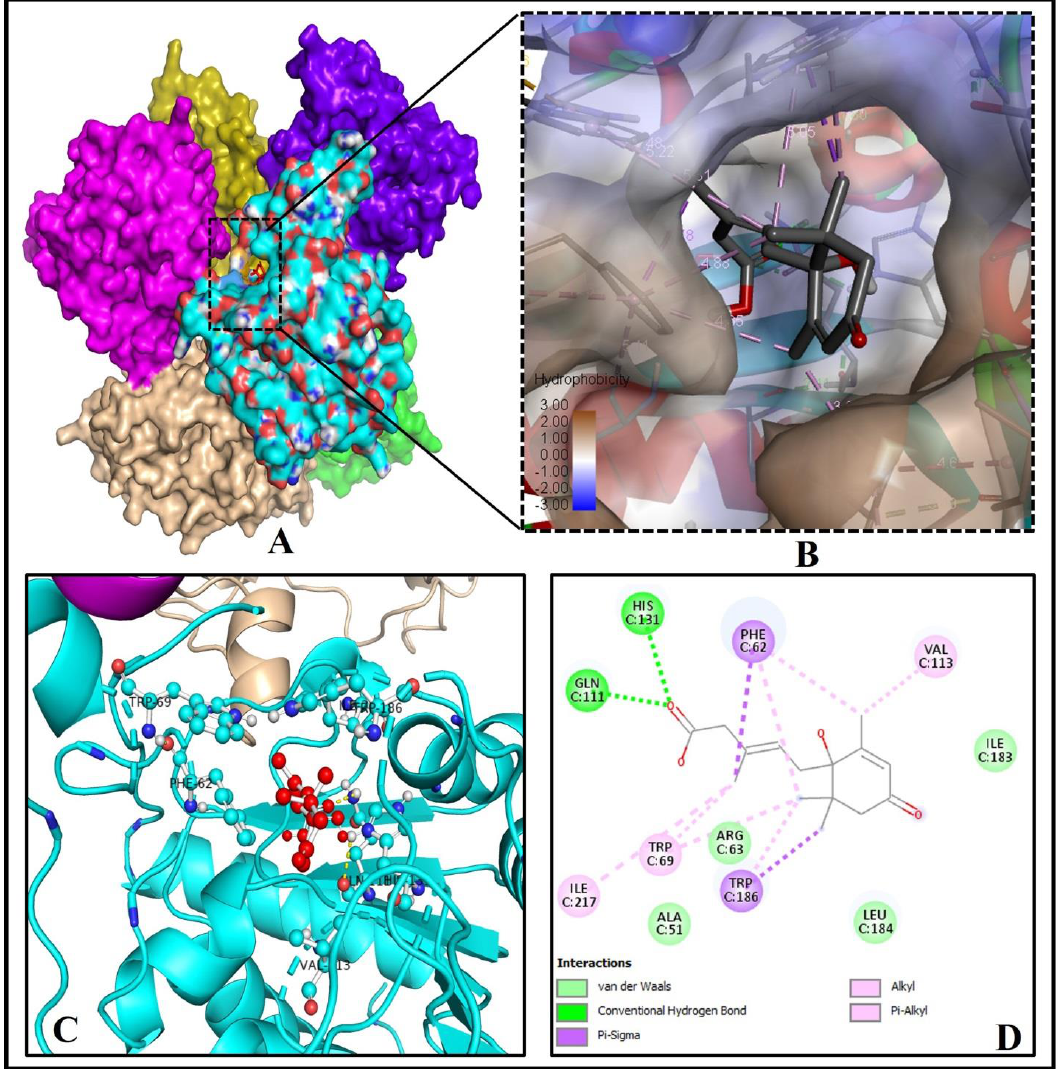
Figure 5. Molecular binding of ABA with human SIRT6 (PDB ID: 3K35). ( A ) ABA binds to the catalytic site. ( B ) Magnified view shows the hydrophobicity of amino acid residues of the binding cavity of SIRT 6 ( C ) 3D image showing interactions of ABA (red ball and sticks) with important residues of human SIRT6 (cyan ball and sticks). ( D ) 2D graph showing interactions at the molecular level pocket residues linked to the ABA.